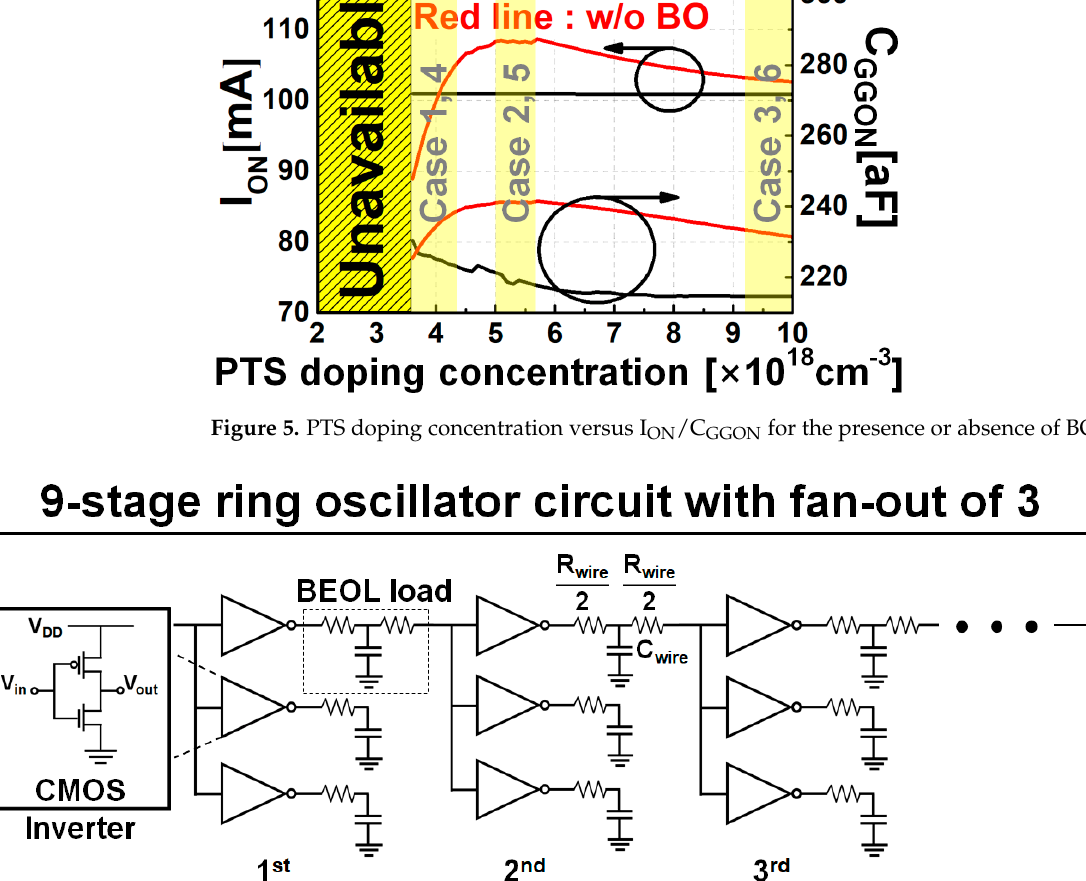
Figure 5. PTS doping concentration versus I ON /C GGON for the presence or absence of BO.